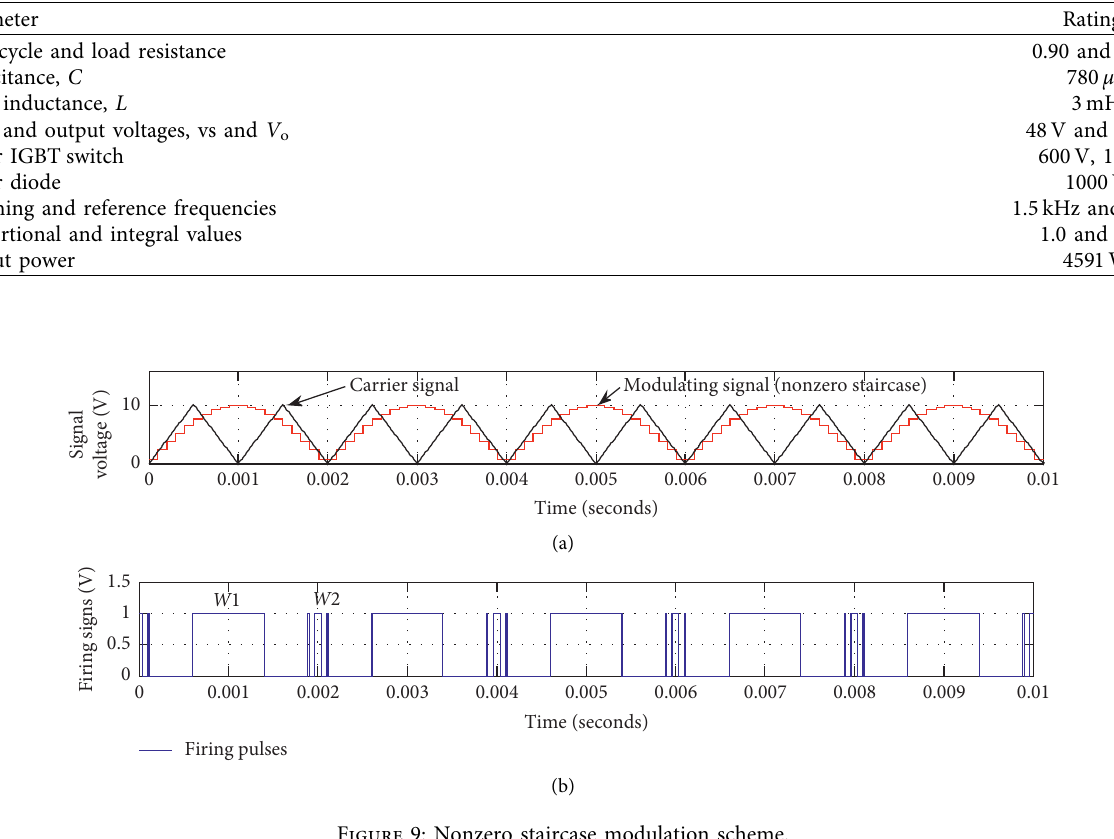
Table 5: Parameters used in the proposed system.